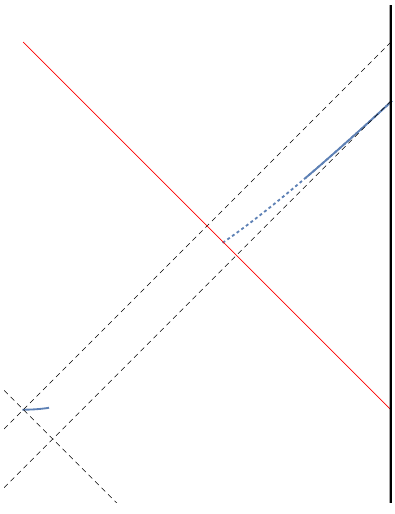
Figure 6 . The location of quantum extremal surfaces as boundary time evolves (solid blue curves). The dashed lines indicate the original horizon before coupling to the bath, and the (cid:12)nal event horizon. The red line indicates the shock at x (cid:0) = 0. The dotted blue line is the non-minimal quantum extremal surface before the Page time phase